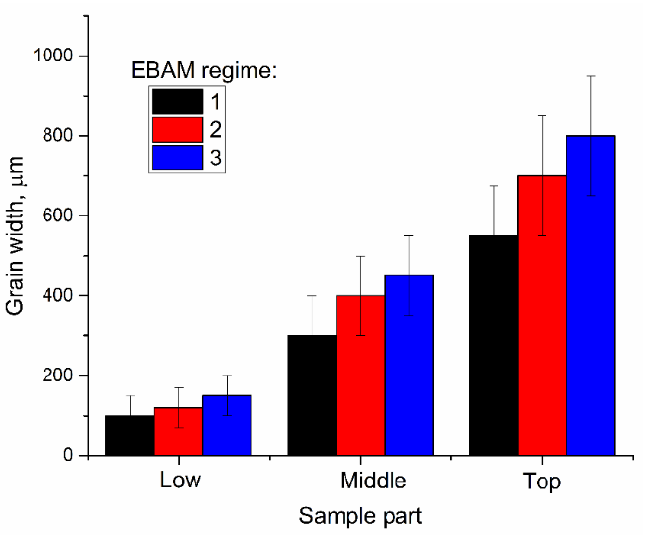
Figure 17. Grain width in different parts of the samples. EBAM regime: (1) 0.21 kJ/mm; (2) 0.255 kJ/mm; (3) 0.3 kJ/mm. (3) 0.3